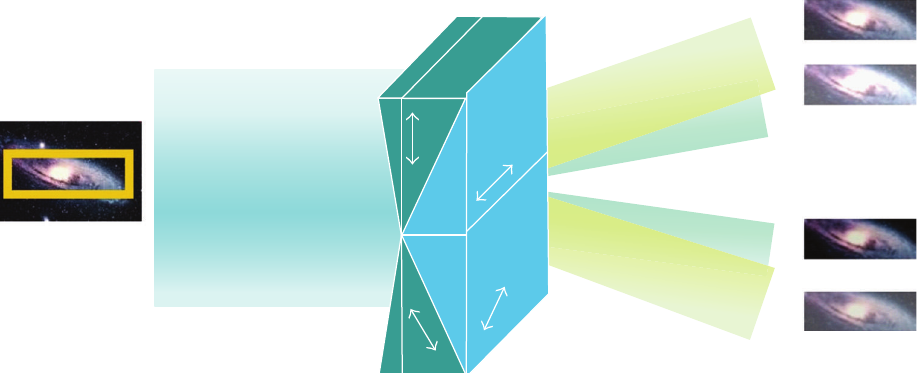
Figure 11: The Wedowo scheme for the Pathos Spectrograph.